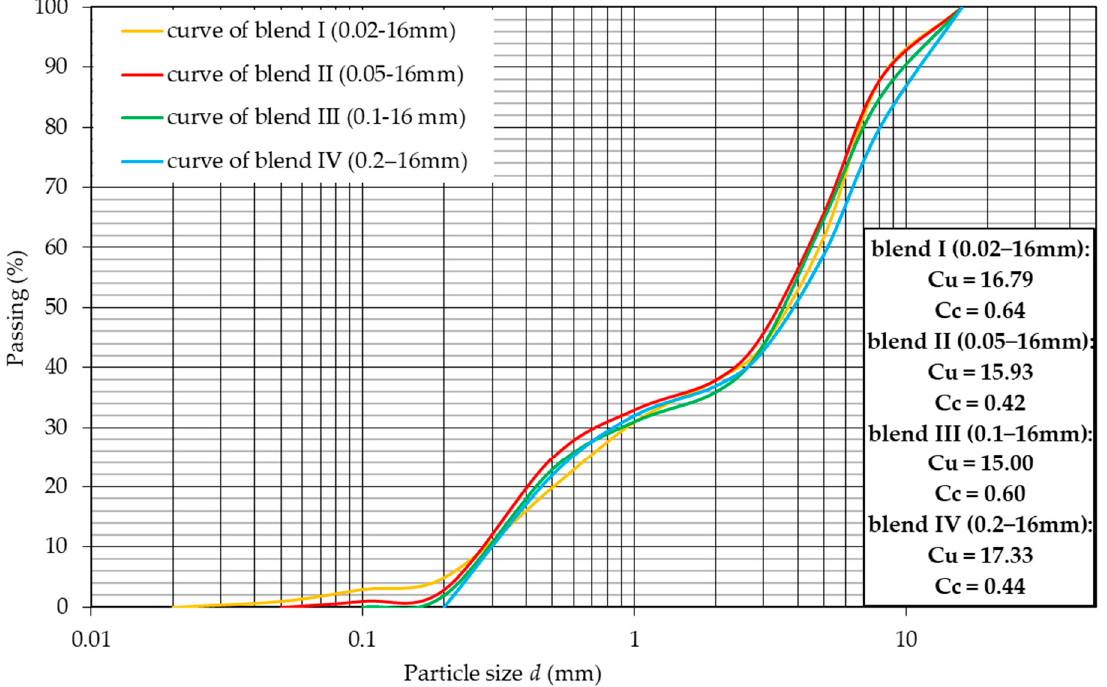
Figure 1. Grain size distribution curve of each tested RCA blends.